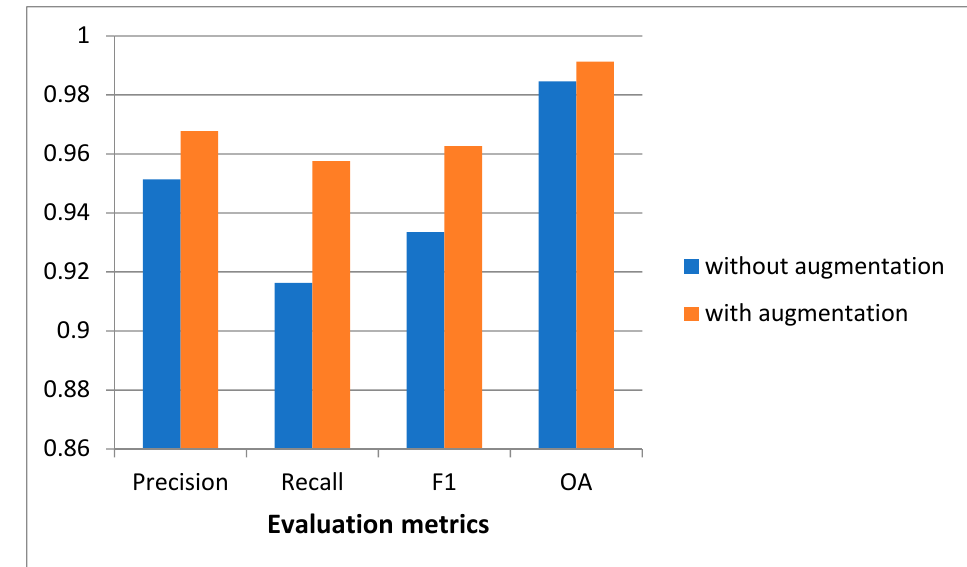
Figure 13. Effect of parameter 𝜆 of loss function on CD results.